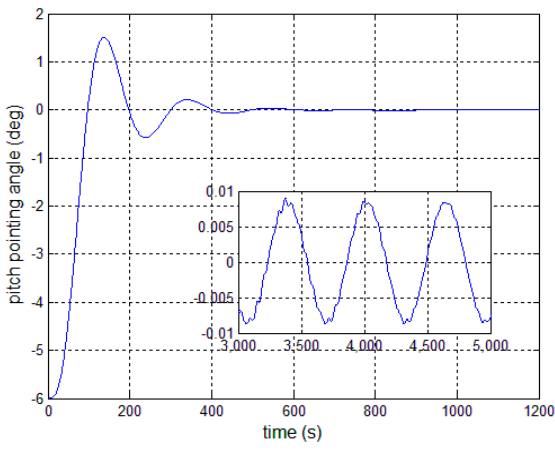
Figure 8. Antenna pitch angle error—controller, Equation (23).